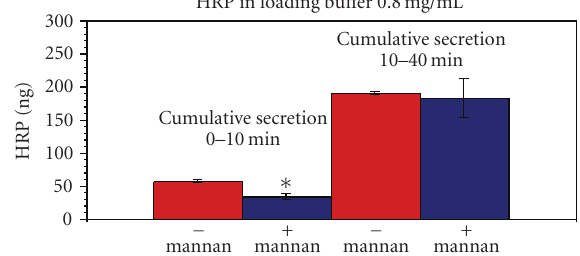
Figure 4: E ff ect of mannan on cumulative HRP secretion. The cumulative secretion from the experiments shown in Figure 2 (absence of mannan) and Figure 3 (presence of mannan) was cal- culated for 0–10 minutes (1st peak) and 10–40 minutes (2nd peak). Data shown are the mean ± SEM from five and four perfusions, respectively. Note that only the first peak (0–10 minutes) was reduced in the presence of mannan. Asterisk indicates significant di ff erences at P ≤ .